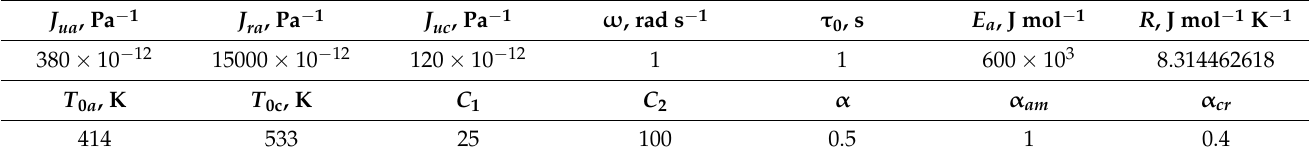
Table 2. Weight coefficients of the mechanisms of crystallization of the PEEK material.